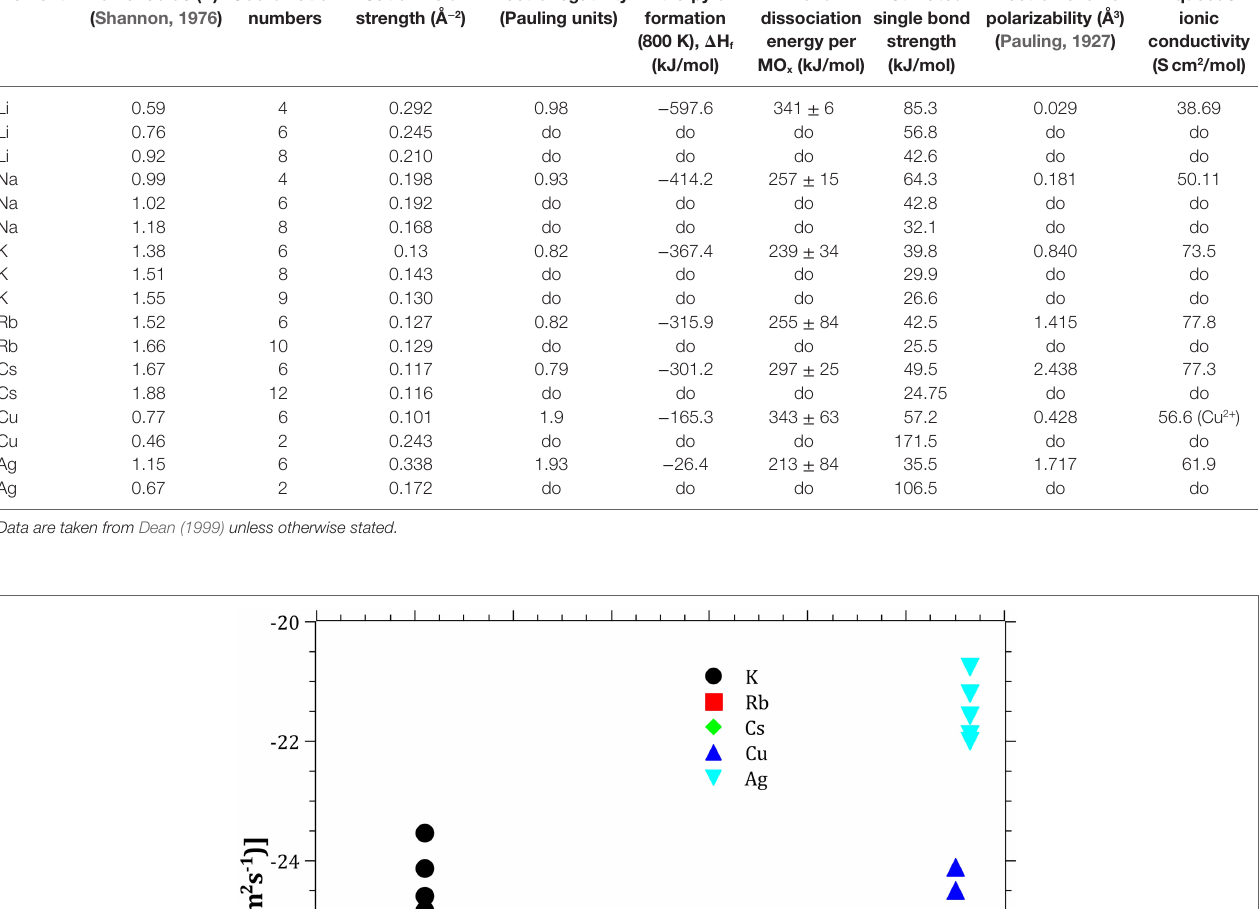
taBLe 4 | data collected for understanding trends in the effective diffusion coefficients, following a representation in Vogel (1994). element ionic radius (Å) Coordination (shannon, 1976)